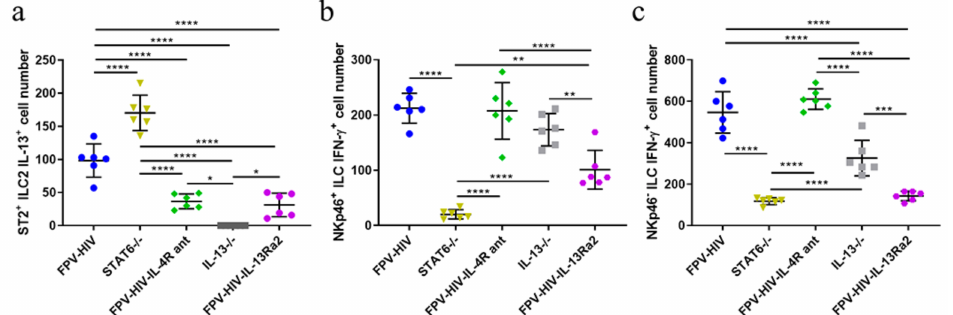
Figure 1. Comparison of ILC2-drived IL-13 and ILC1/ILC3-drived IFN- γ expression following rFPV vaccination under permanent (knock out mice) vs. transient inhibition of IL-13 and STAT6. Color coded vaccine groups represent: blue, WT BALB/c given FPV-HIV (control); yellow, STAT6 − / − given FPV-HIV (which represents permanent STAT6 signaling inhibition condition); green, WT BALB/c given FPV-HIV-IL-4R antagonist vaccine (which represents transient IL-4/IL-13/STAT6 signaling inhibition condition); grey, IL-13 − / − given FPV-HIV (which represents permanent IL-13 inhibition condition); and purple, WT BALB/c given FPV-HIV-IL-13 α 2 adjuvanted vaccine (which represents transient IL-13 sequestration/inhibition condition). Graphs represent IL-13 expression by lung IL- 33R/ST2 + ILC2 ( a ) and IFN- γ expression by lung NKp46 − /+ ILC1/ILC3 ( b , c ) following IL-13 − / − and STAT6 − / − BALB/c background mice (n = 4) given the control unadjuvanted vaccine (FPV-HIV) compared to BALB/c mice (n = 4) given FPV-HIV unadjuvanted, FPV-HIV-IL-4R antagonist, and FPV-HIV-IL-13R α 2 adjuvanted vaccines. The error bars represent the mean and standard deviation (s.d.). The p values were calculated using One-way ANOVA using Tukey’s multiple comparisons test and unpaired t -test. * p < 0.05, ** p < 0.01, *** p < 0.001, **** p < 0.0001. Experiments were repeated